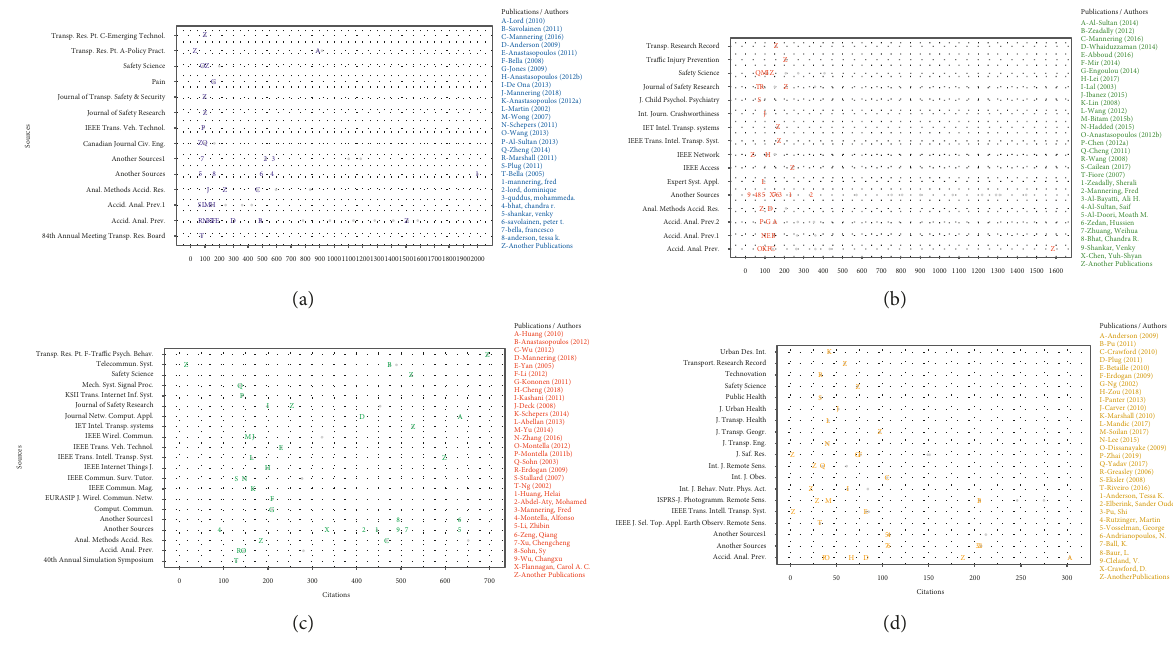
Figure 2: Most cited papers, authors, and journals for the (a) RTA +HA +SM, (b) RTA +HA+ ML, (c) RTA+HA +SC, and (d) RTA+HA +GIS